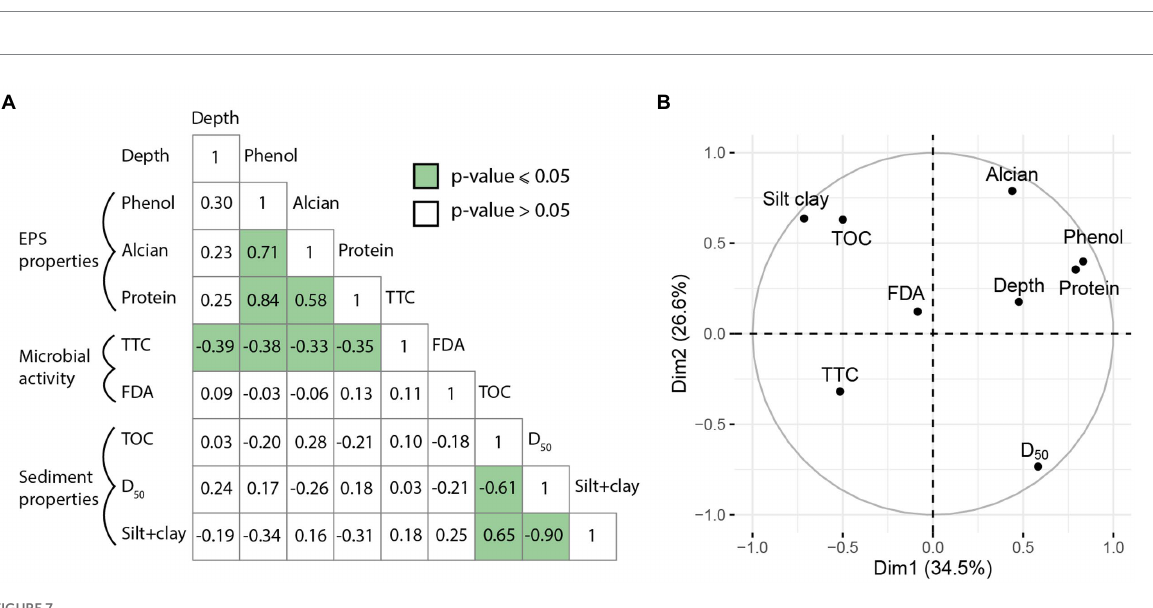
FIGURE 6 Acid–base titration curves from exopolymeric substances (EPSs) extracted from the surface biofilm and the bottom of the BXN Long Core (depth = 6.08 m). The titration curves obtained were analyzed using PROTOFIT 2.1 software, and both show three buffering zones. The first zone located around pH 2 is attributed to carboxyl or sulfate groups, the second zone located near pH 5 is attributed to carboxyl groups, and the third buffering zone near pH 9.5 is attributed to amino groups. Control titration was performed using the same volume of deionized water adjusted to the same initial pH with HCl 1